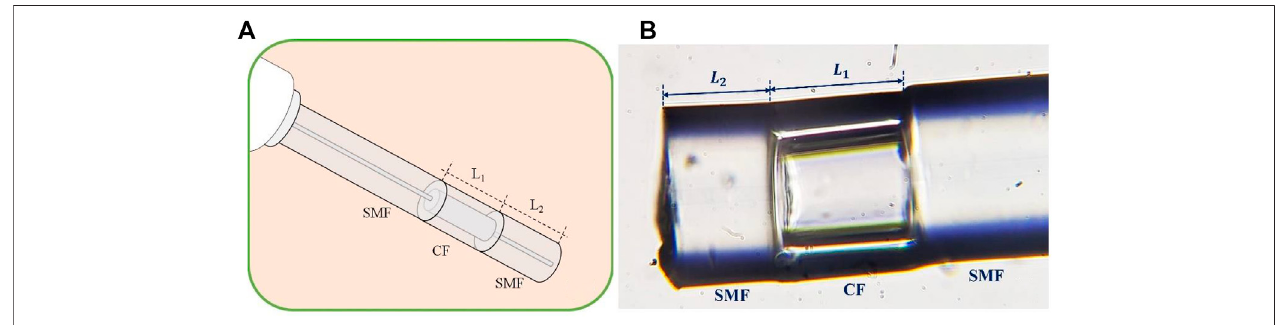
FIGURE 1 | (A) Schematic representation and (B) microscope image of an